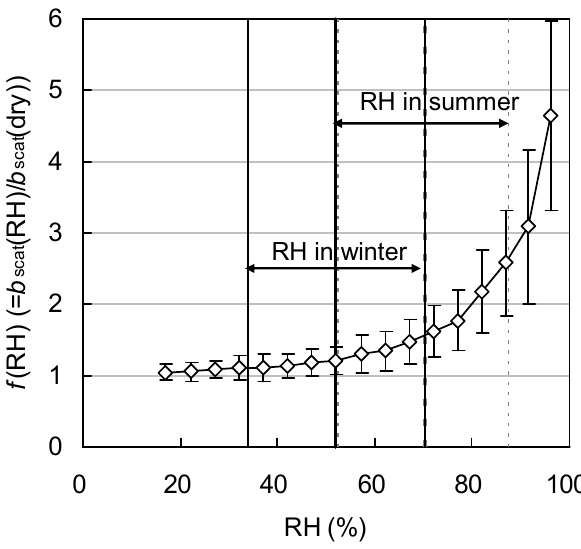
Fig. 7. Humidity dependence light scattering enhancement factor, f (RH) (= b scat (RH)/ b scat (dry)). Error bars represent 1 σ . Bold vertical solid and dotted lines represent average RH in winter and summer, respectively. Arrows indicate 1 σ